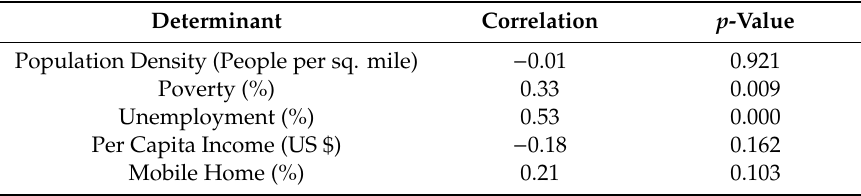
Table 6. Correlations between COVID-19 case fatality (%) and social and health determinants in Colorado. Determinant Correlation p -Value Population Density (People per sq. mile)